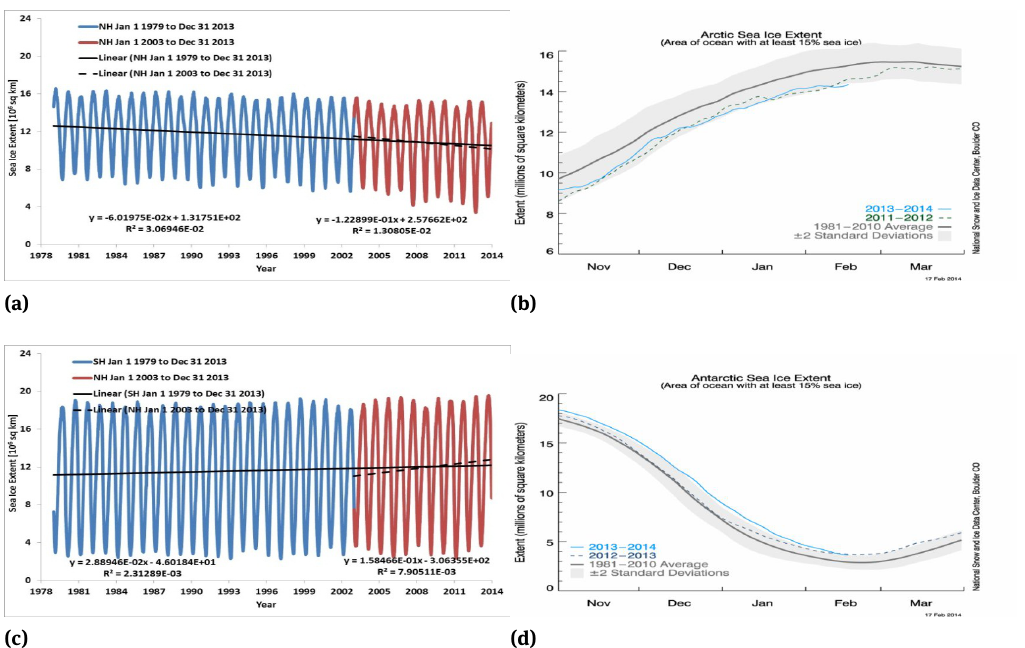
Fig. 5. Measured sea ice extents for the North and South Poles: a, b: time histories of sea ice extent (data from NSDIC [10]). Data analysed since 1978 and over the last 11 years; c, d: present seasonal trends for the North and South Poles indicating below average extents (figures from NSDIC